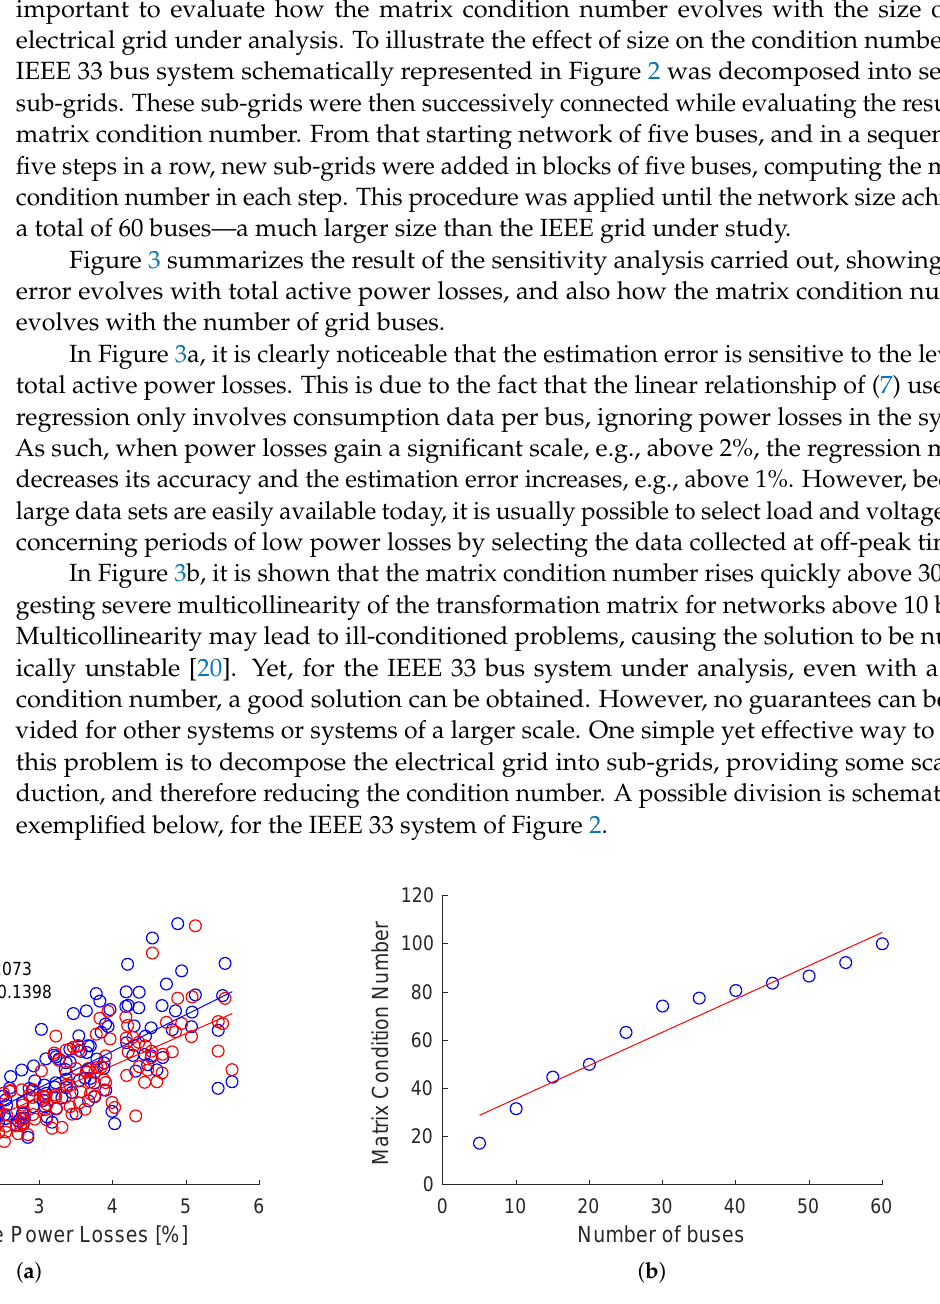
Figure 3. Sensitivity Analysis: ( a ) Parameter error evolution with total active power losses. ( b ) Matrix condition number evolution with the number of network